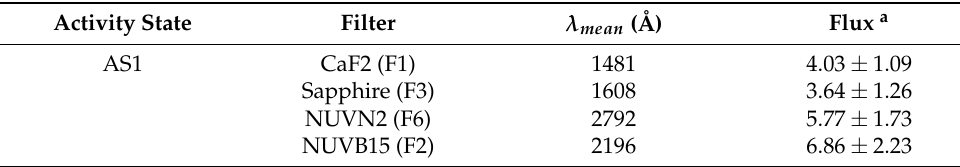
Table 5. AstroSat -UVIT analysis